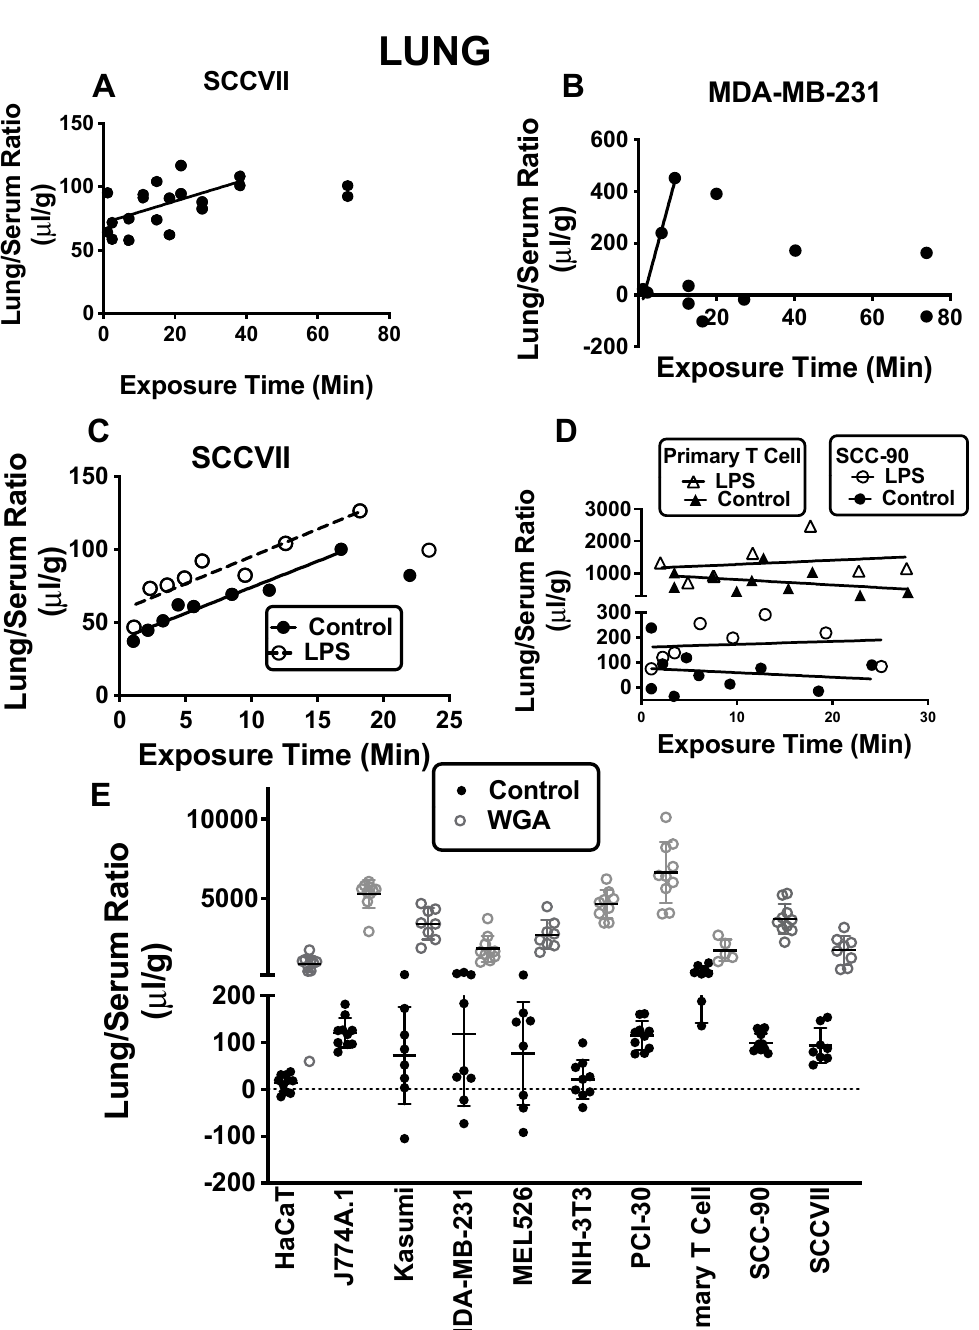
Figure 3. Lung sequestration of exosomes. In lung, only SCCVII and MDA-MB-231 showed time- dependent sequestrations. SCCVII (n = 20) showed a hyperbolic pattern ( A ) and MDA-MB-231 (n = 12) showed a decline following its initial increase ( B ). Modest increases were induced by LPS for exosomes whose sequestration either increased (( C ); n = 9/group) or was stable (( D ); n = 10 for each control; n = 7 for Primary T cell LPS; n = 8 for SCC-90) over time. In ( E ), WGA dramatically increased sequestration of each of the exosomes to a statistically significant level (n = 10 for control and WGA for HaCaT, J774A.1, PCI-30, SCC-90, and MDA-MB-231 WGA; n = 9 for control and WGA for MEL526 and NIH-3T3; n = 9 for controls for MDA-MB-231 and Primary T cell; n = 8 for control and WGA for Kasumi and SCCVII; n = 5 for WGA for Primary T cell). See Figure S2 for exosomes not shown here. Regression analysis was used in panels ( A – D ) and t -tests in panel ( E ). p << 0.001 for each